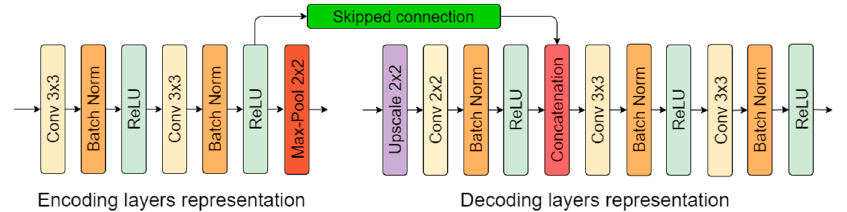
Figure 2. Encoding- and decoding-part layer representation.